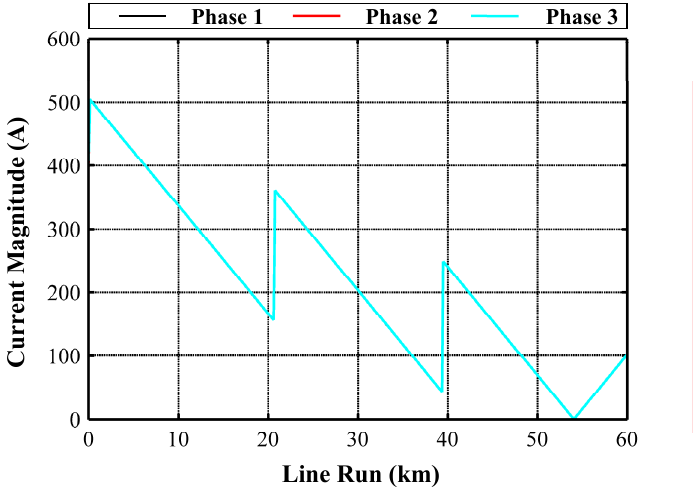
Figure 12. Phase current magnitudes along the compensated UGC in CB with PTs at no-load.